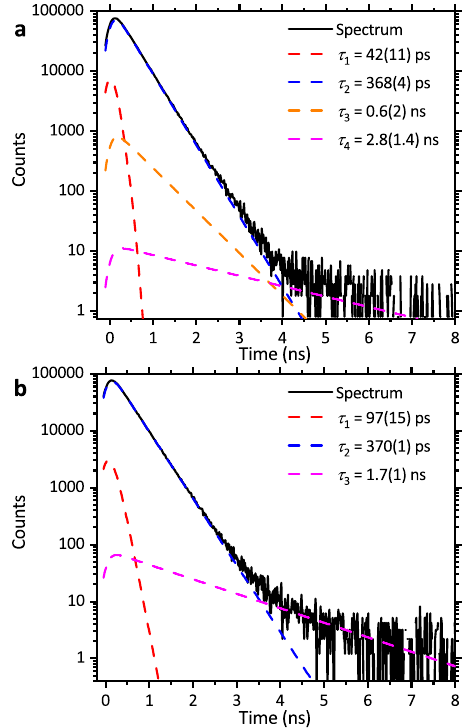
Fig. 4 Experimental positron lifetime spectra with deconvolution fi t components. a MAPbI 3 crystal with 4 keV implantation energy, both also showing the fi tted positron lifetime components. b The 300 nm MAPbI 3 fi lm (Liverpool, Anneal A) measured with 2.5 keV positron implantation